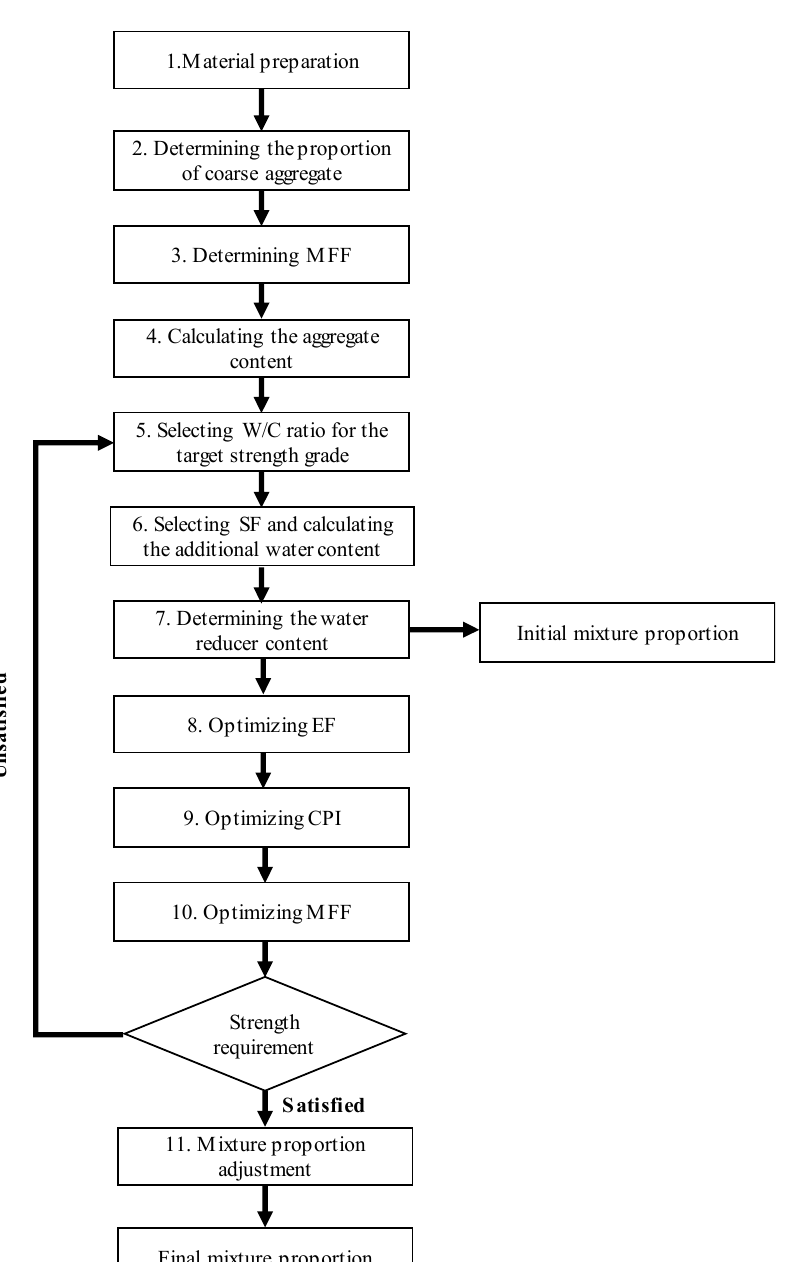
Figure 2. Flow chart of the procedure proposed for concrete mix design.